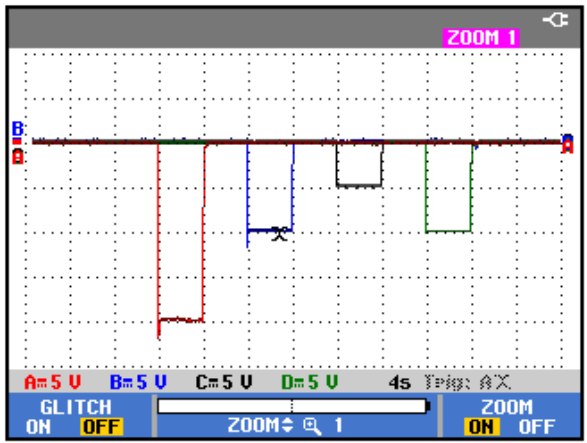
Figure 17. DGUs output currents during sequential voltage attacks.